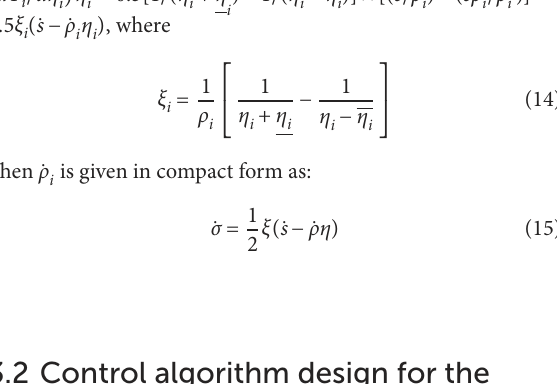
FIGURE 2 Nominal formation of 7 agents.